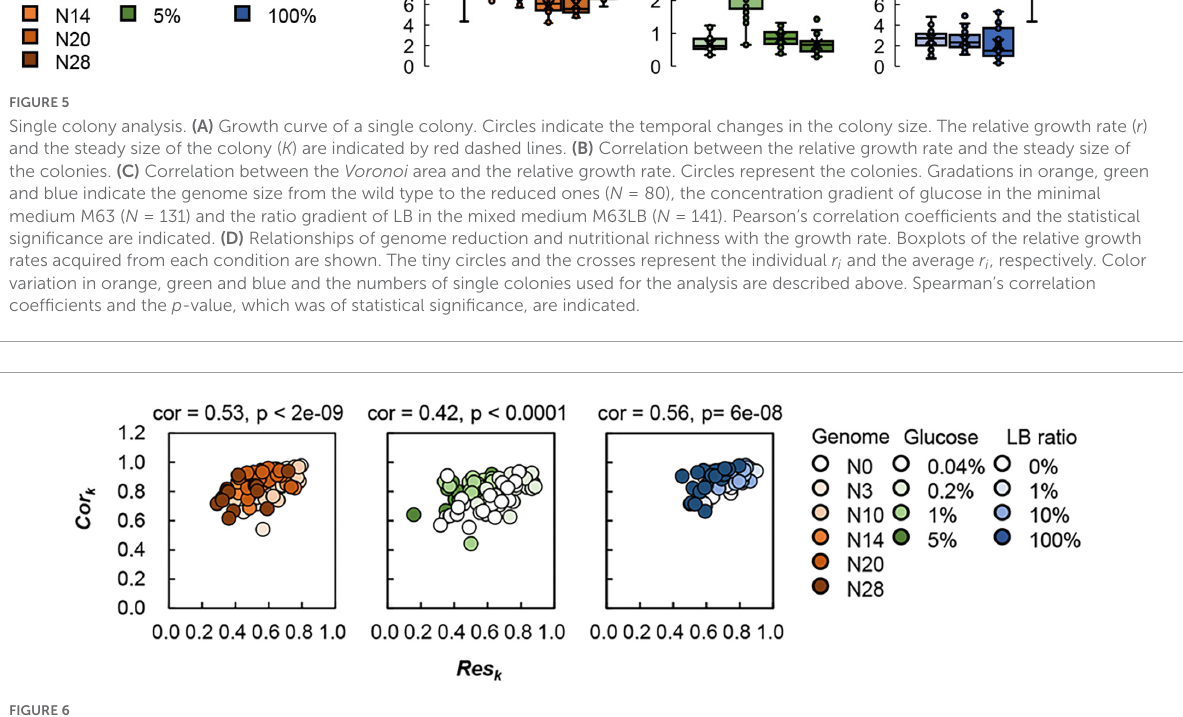
were changed due to genomic and nutritional interruptions, which indicated that the efficiency of resource utilization was different depending on the genome and environment. Although Cor k remained approximately steady, its slight